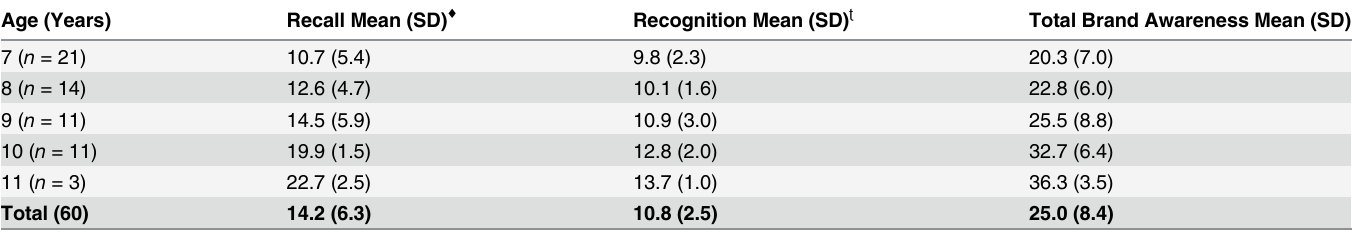
Table 1. Mean score of responses for the brand recall, brand recognition and total brand awareness for each age category.